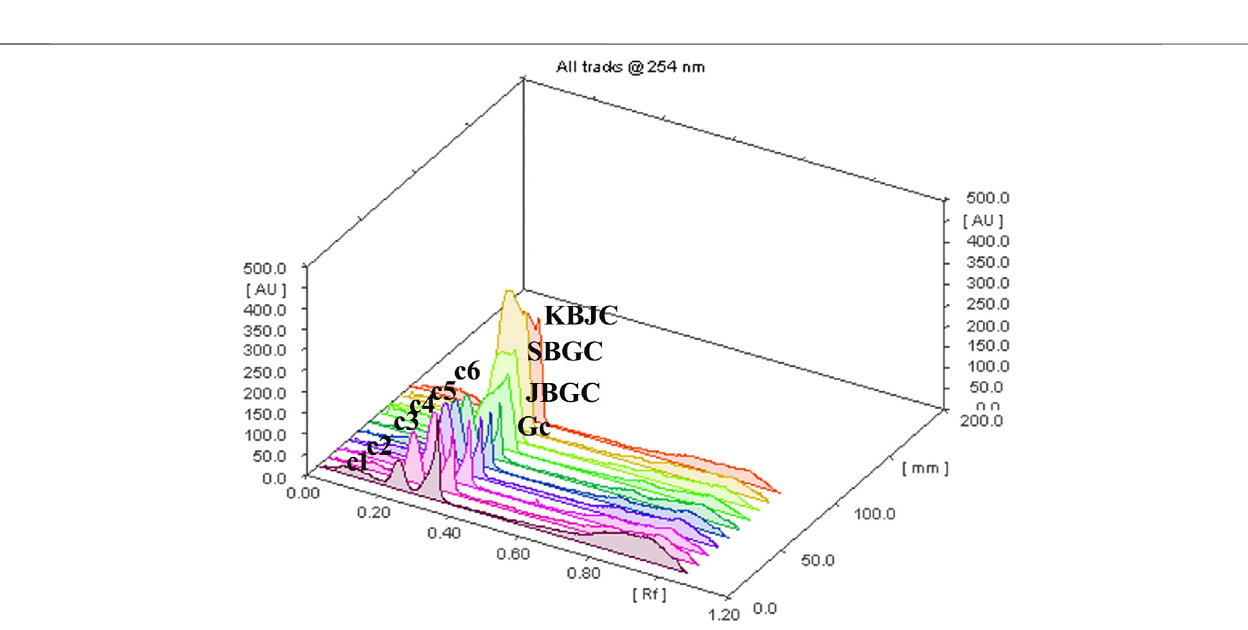
Frontiers in Pharmacology |